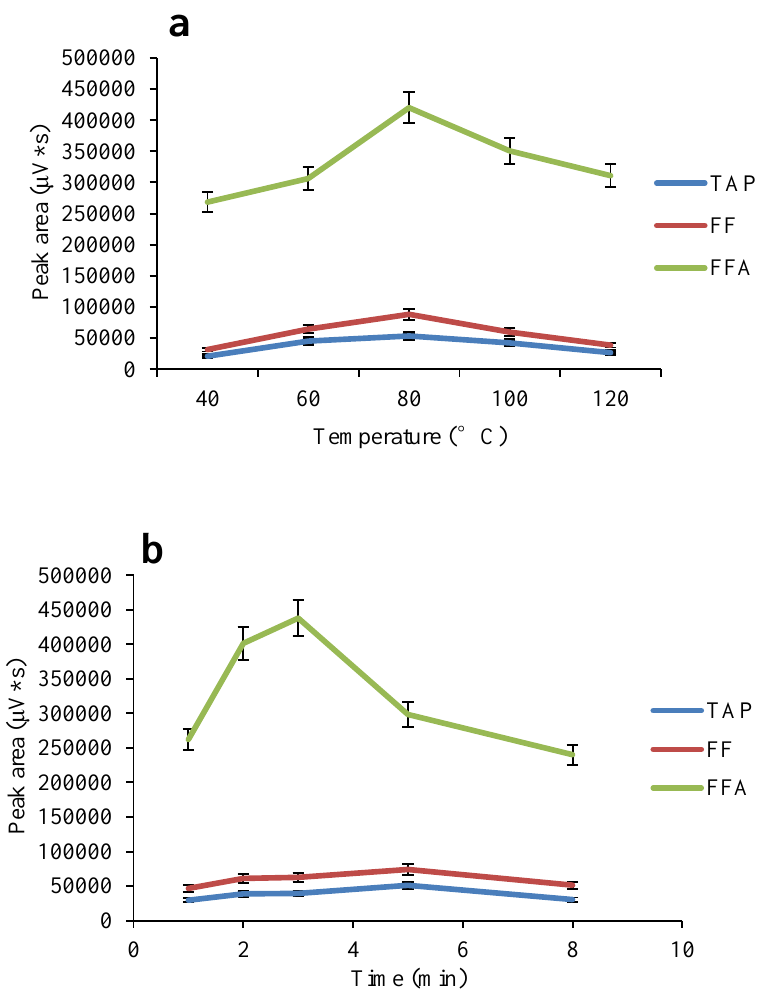
Figure 3. E ff ects of temperature ( a ) and time ( b ) on ASE extraction. Figure 3. Effects of temperature ( a ) and time ( b ) on ASE extraction. Table 3. The linear ranges, linear regression equations, determination coe ffi cients, LODs and LOQs of TAP, FF and FFA from poultry